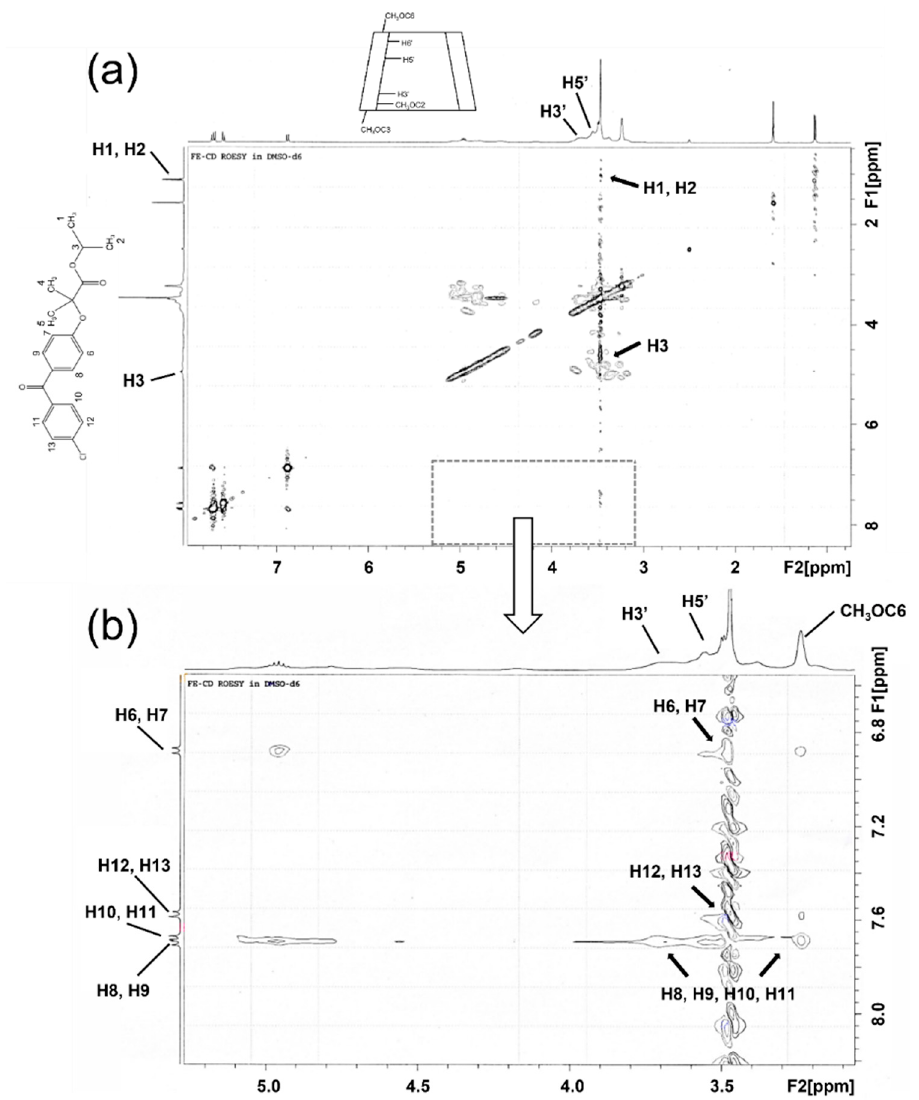
Figure 3. 2D ROESY spectrum of the FE/RM β CD complex in DMSO- d 6 . The cross peaks of FE protons and inner protons of the RM β CD cavity are shown in two views: ( a ) the whole region and ( b ) the expanded region.